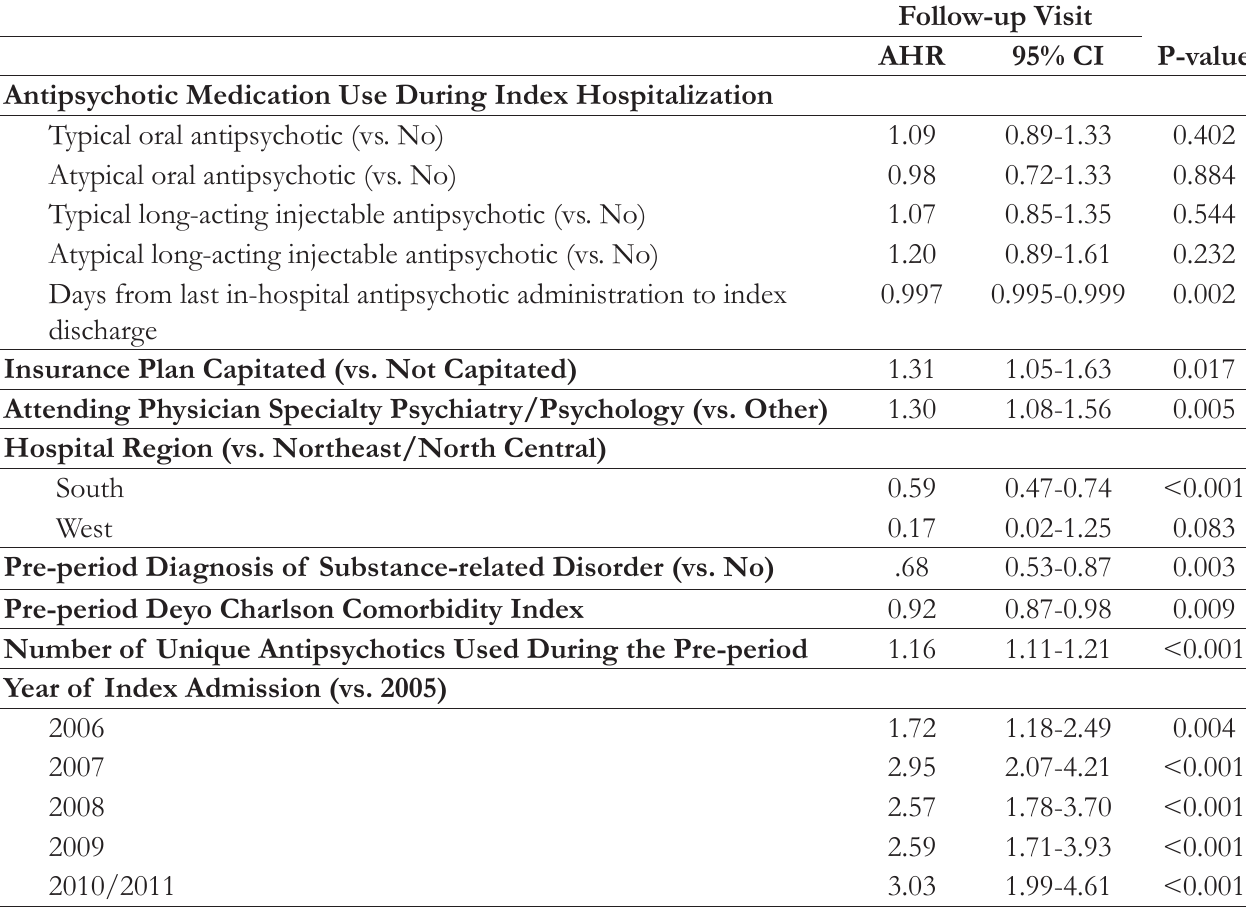
Table 4. Cox Proportional Hazards Model Results